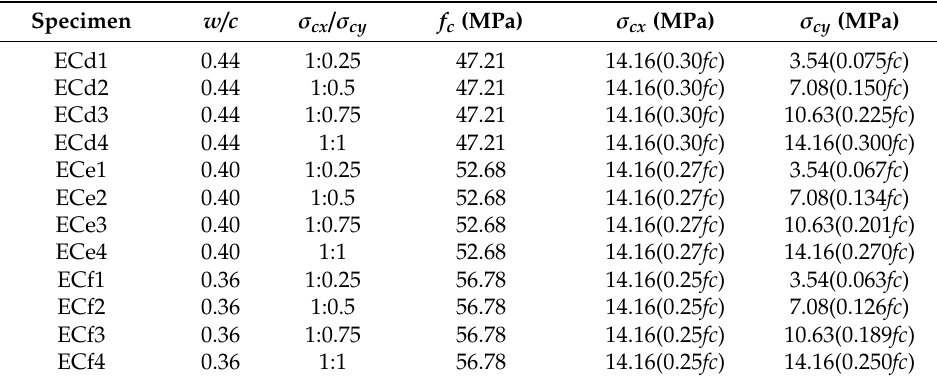
Table 4. Test specimens under biaxial